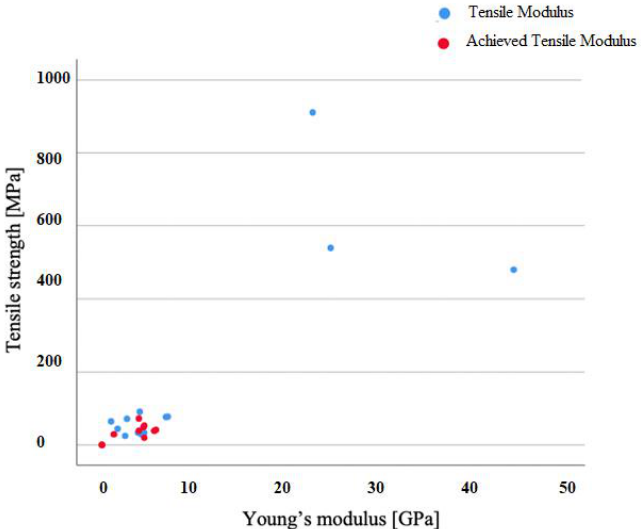
Figure 6. Tensile properties of ACCs from literature presented in [20] (blue dots) and measured tensile properties from this study (red dots).